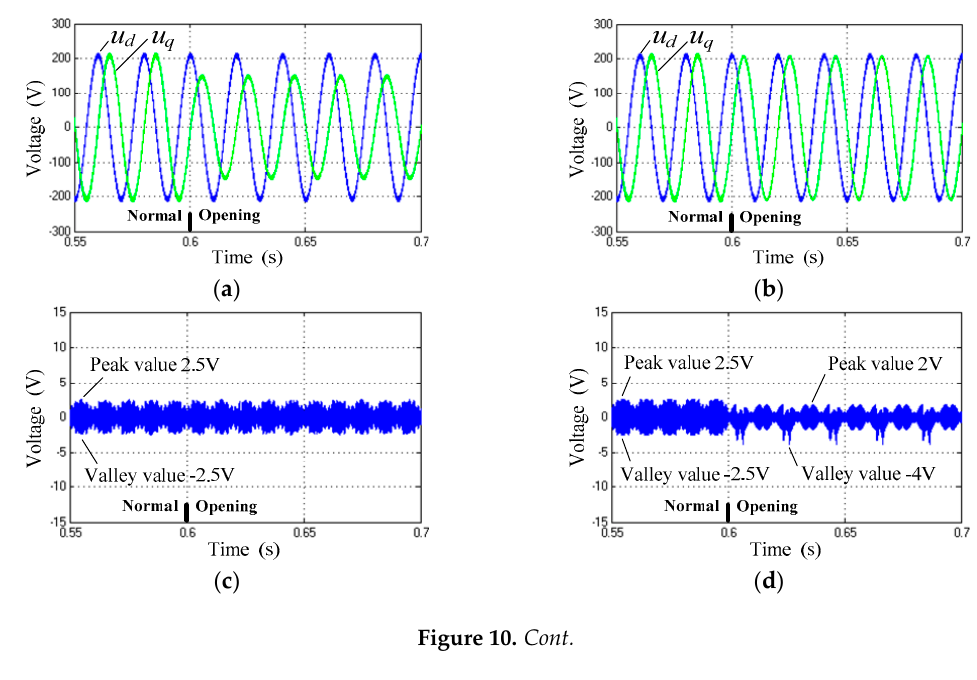
Figure 9. Stator winding voltages by low-pass filtering in simulations 1 and 2. ( a ) Stator winding voltages in simulation 1; ( b ) Stator winding voltages in simulation 2; ( c ) ACE-winding voltages in simulation 1; ( d ) ACE-winding voltages in simulation 2; ( e ) BDF-winding voltages in simulation 1; ( f ) BDF-winding voltages in simulation 2.